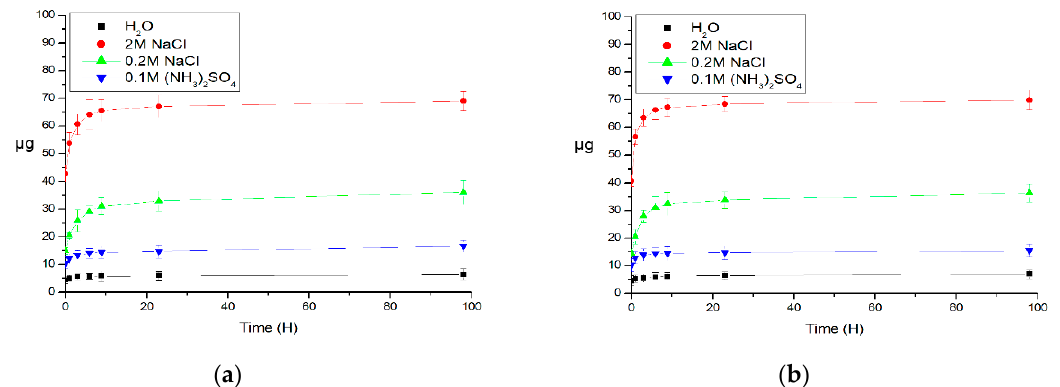
Figure 3. Dependence of the mass of FITC-labeled BSA in the supernatant on the incubation time of polyelectrolyte microcapsules, at room temperature (22 °C) ( a ) and at 37 °C ( b ) in the presence of salts.